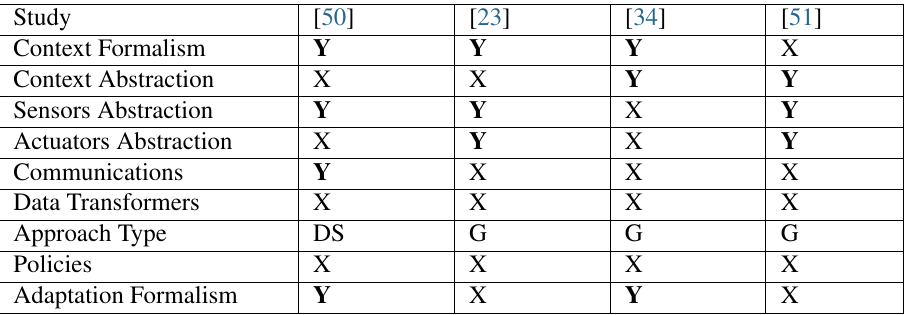
Generic approaches. Table 9. Comparison Between Context-Aware Approaches Part-2